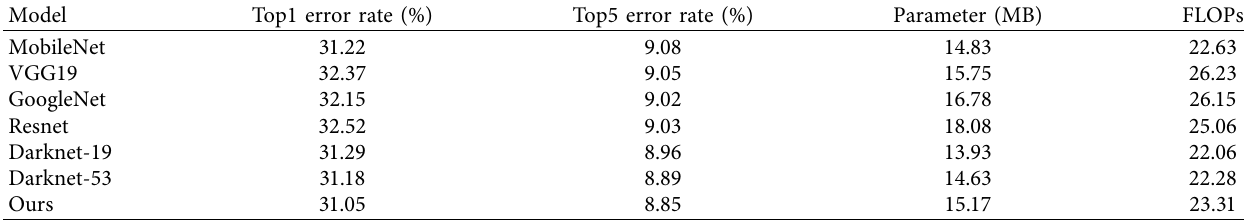
Table 1: Comparison of calculation results of different basic networks.